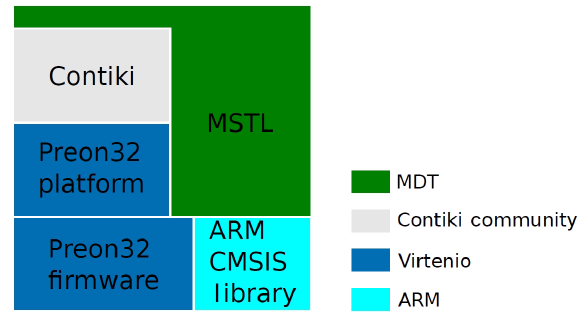
Figure 2. The architecture of the WSN